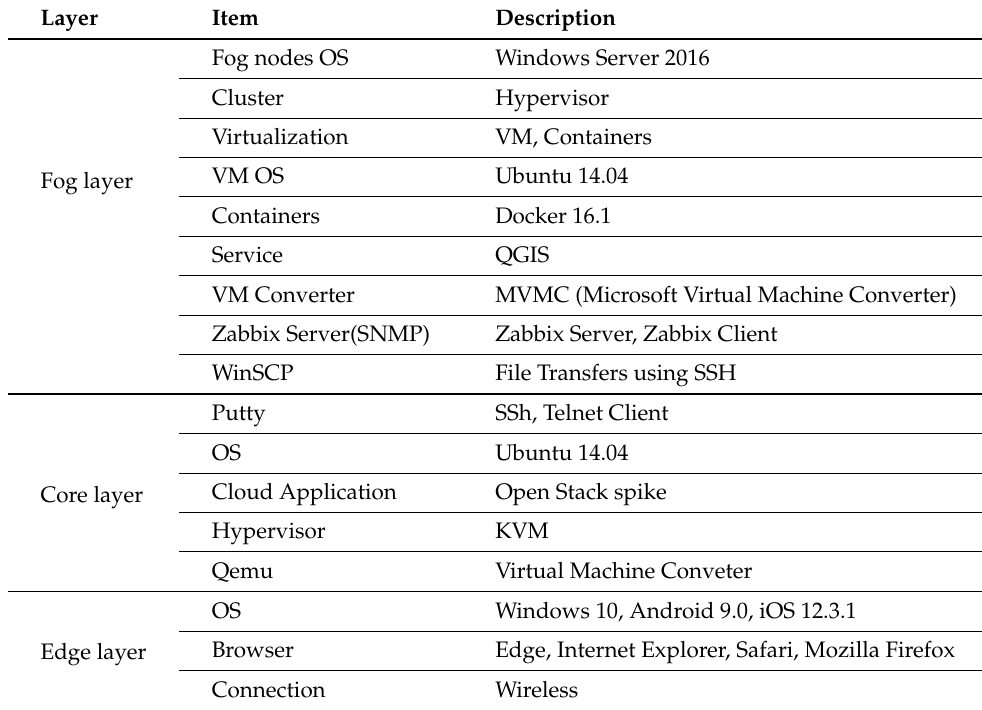
Figure 3. Architecture of core layer. Table 4. Software used for the proposed